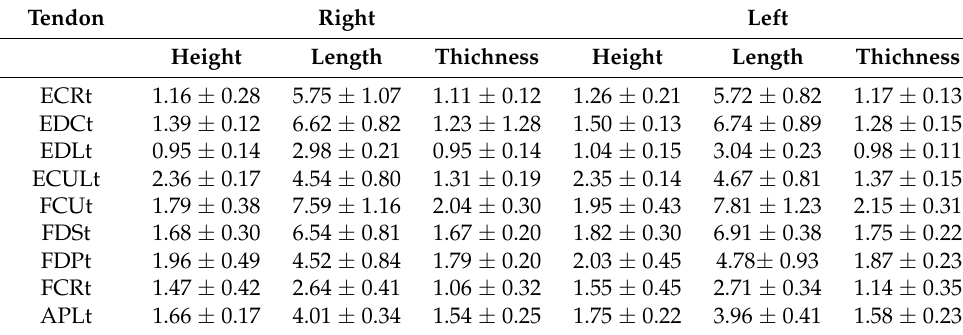
Table 1. The height and the length were obtained at the radial ulnar notch level in a transverse scan plan image of the tendon. The height was the short axis, and the length was the long axis of the tendon. The thickness was obtained in a longitudinal scan plan of the tendon at the same level and was the shot axis. All the measurements were made in